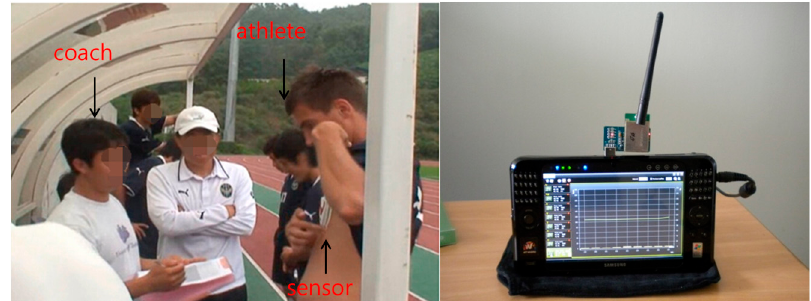
Figure 10. Heart rate correlation between proposed sensor and standard system.